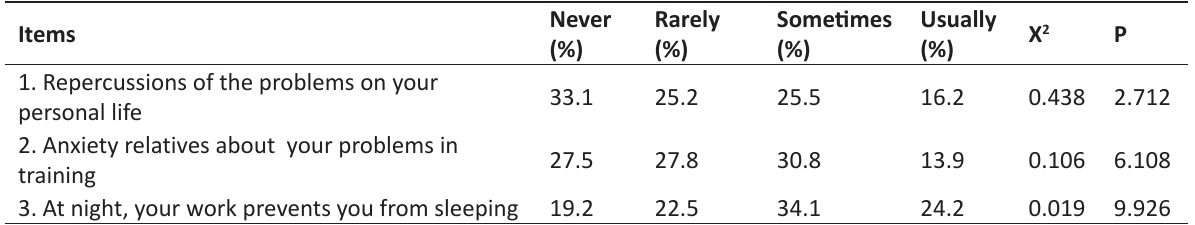
Table 3. The different items of life repercussions